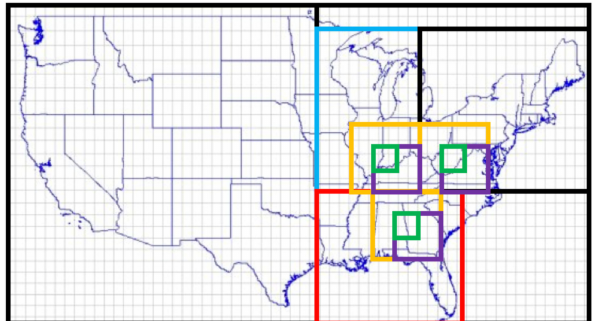
Figure 1. Telescoping spatial regions included in this study. The largest scale we consider is the continental US (outer border). We focus on the eastern US by subdividing into three subregions: the midwest (blue), northeast (black), and southeast (red). Within each subregion we telescope into a 3 × 3 grid cell (yellow) a 2 × 2 grid cell (purple), and a 1 × 1 grid cell (green). In the paper, we only show a subset of these telescoping regions, and we include the rest in the